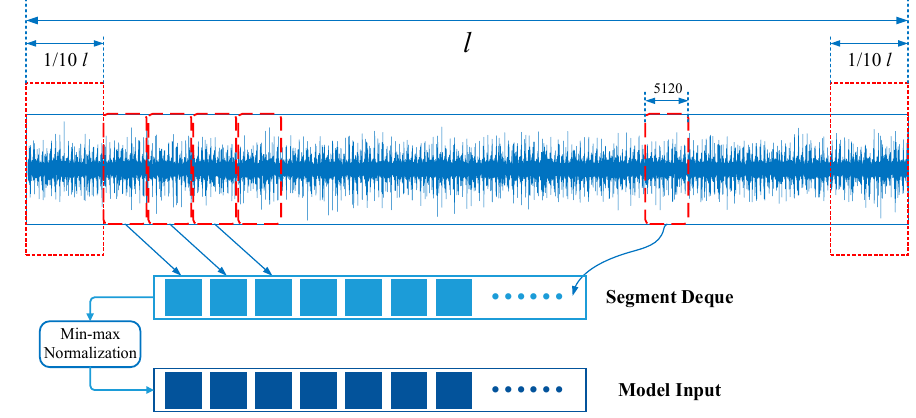
Figure 5. Schematic diagram of data preprocessing.